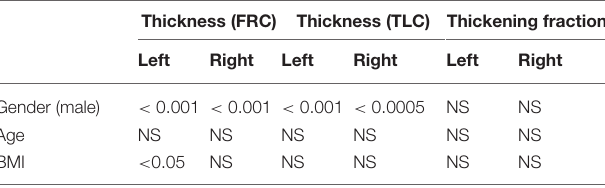
TABLE 4 | Linear regression analysis assessing the association between the diaphragmatic thickness and the demographic and the BMI data. Thickness (FRC) Thickness (TLC) Thickening fraction Left Right Left Right Left